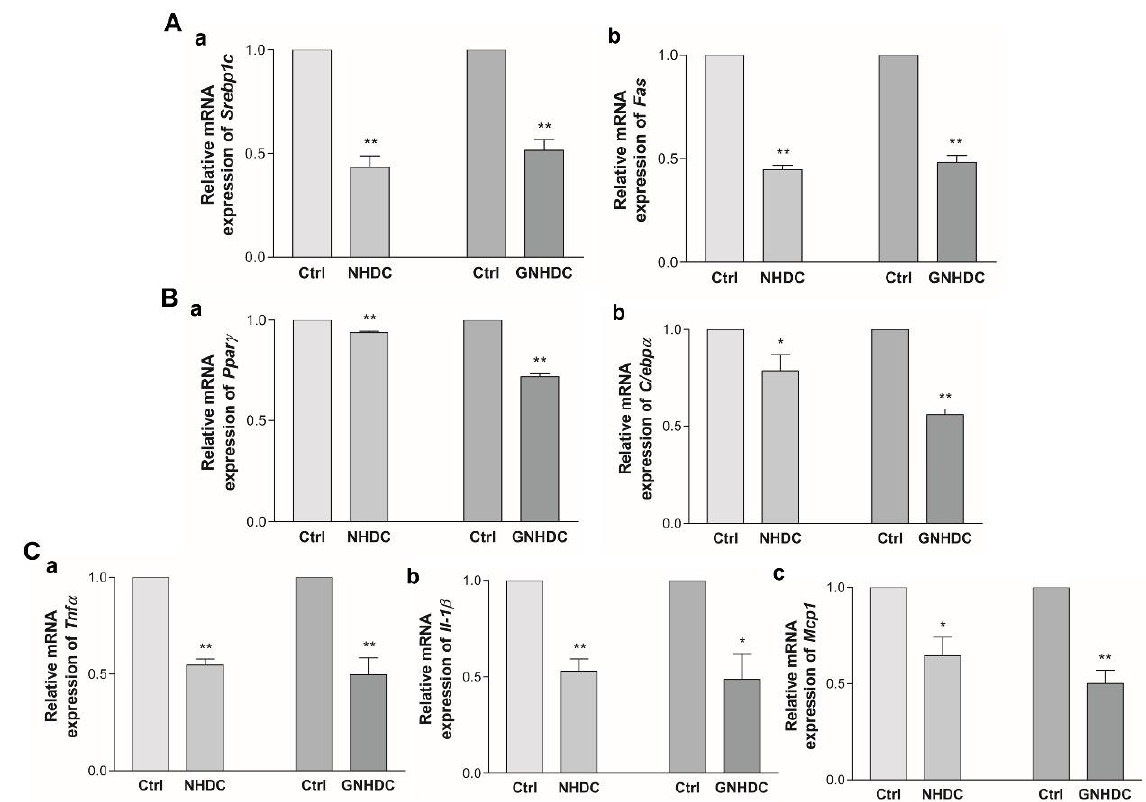
Figure 5. Effects of NHDC and GNHDC on lipogenesis, adipogenesis, and proinflammatory cytokines in 3T3-L1 cells. Expression of mRNA was analyzed for ( A ) lipogenesis-related genes, ( a ) Srebp1c and ( b ) Fas , ( B ) adipogenesis-related genes, ( a ) Pparγ and ( b ) C/ebpα , ( C ) proinflammatory cytokines-related genes, ( a ) Tnfα , ( b ) Il-1β , and ( c ) Mcp1 . All data are shown as the mean ± SEM and were analyzed by an unpaired Student’s t -test ( n = 3–4). Each asterisk indicates significant difference as compared to Ctrl; * ( p < 0.05) and ** ( p < 0.01). C/ebpα , CCAAT/enhancer binding protein alpha; Fas , fatty acid synthase; Il-1β , interleukin 1 beta; Mcp1 , monocyte chemoattractant protein 1; Pparγ , peroxisome proliferator-activated receptor gamma coactivator 1 alpha; Srebp1c , sterol regulatory el- ement-binding protein 1; Tnfα , tumor necrosis factor alpha; Ctrl, control; NHDC, neohesperidin di-